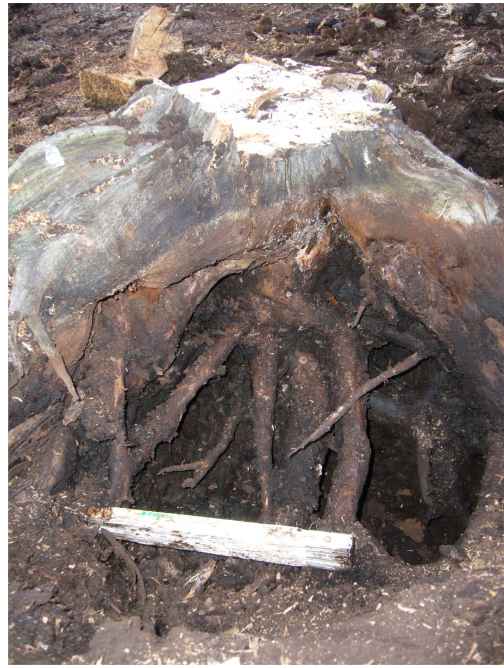
Figure 9. Strong downward roots below a tree stump at TOMO_south (tree life 5396–5230 BC, chronology segment B). Photo: Inke Achterberg.